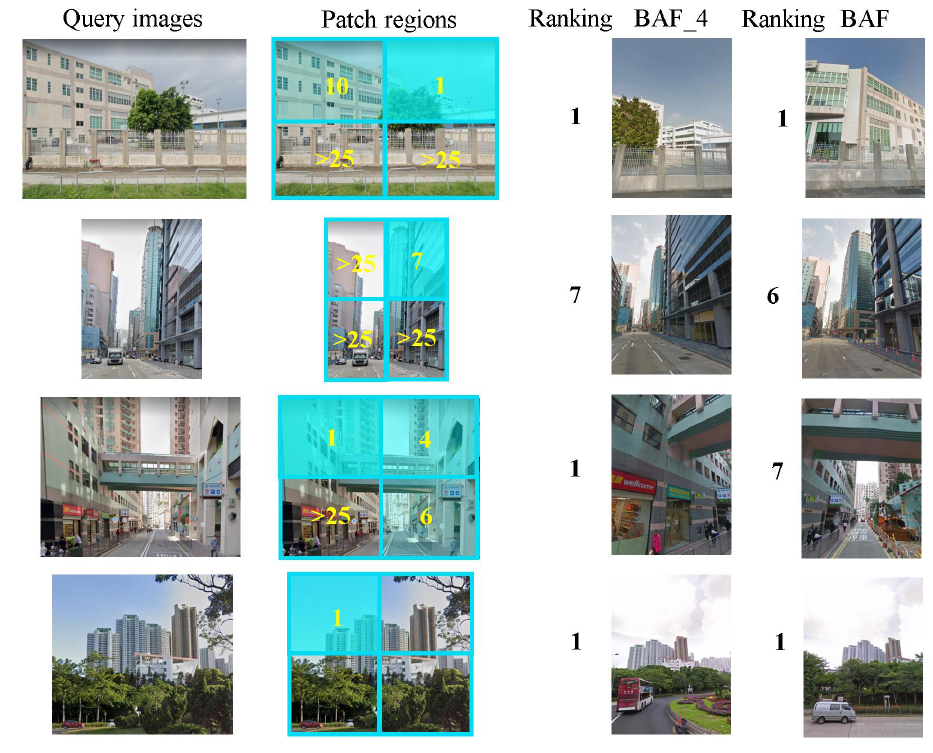
Figure 12. Improvement of patch-region retrieval method to the results: in improvement of ranking of the correct